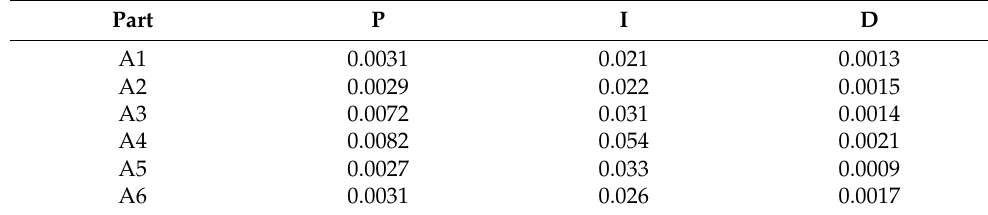
Table 3. Parameters for PID Control Scheme.